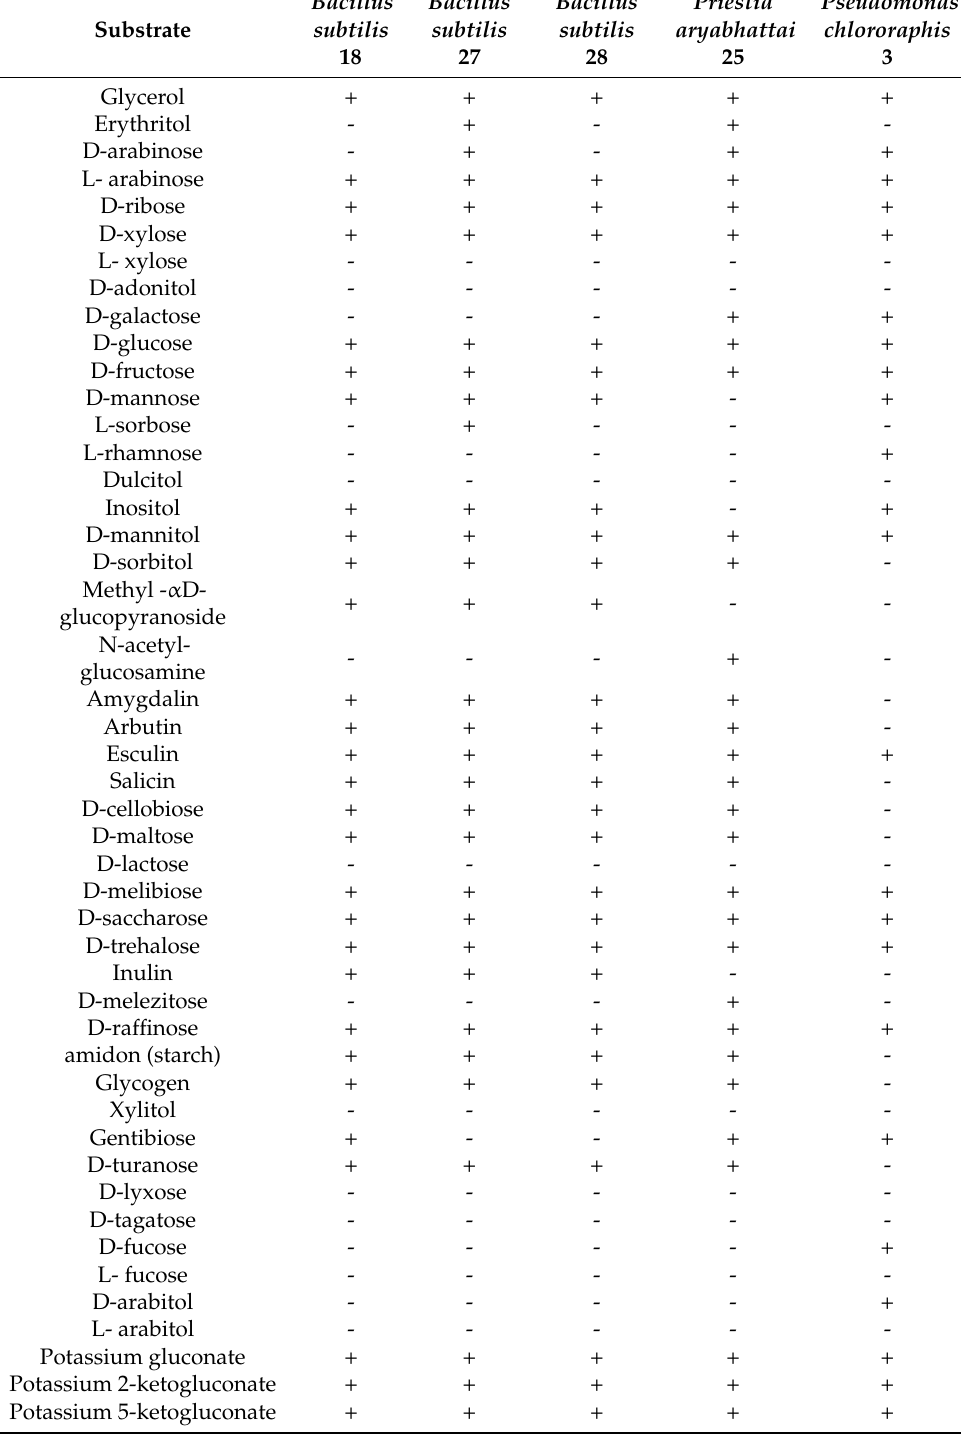
Table 3. Range of the utilized substrates by soil